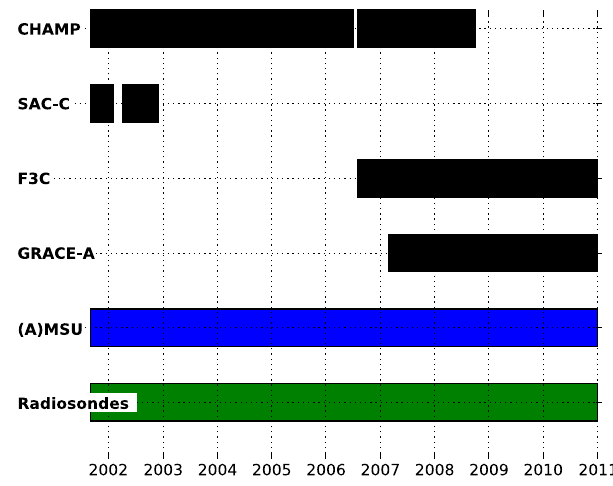
Fig. 1. Time frames of datasets used (black, GPS RO